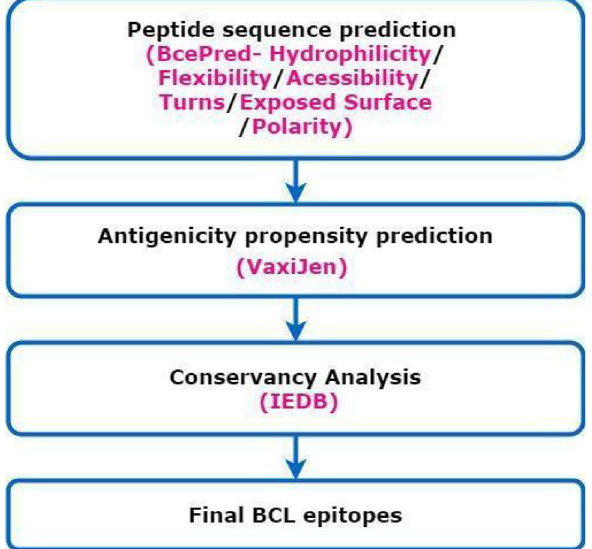
Figure 3. Workflow for the selection of B-cell epitope sequences (Draw.io—https:// www. diagr ams. net/- 14.6.